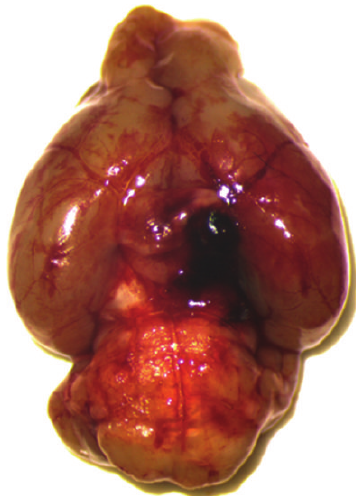
Figure 1: Perfused mouse brain three hours after experimental SAH (endovascular perforation model). A large clot formed at the perfo- ration site (dotted white circle), and blood is distributed from the bleeding site into the subarachnoid space, preferentially along blood